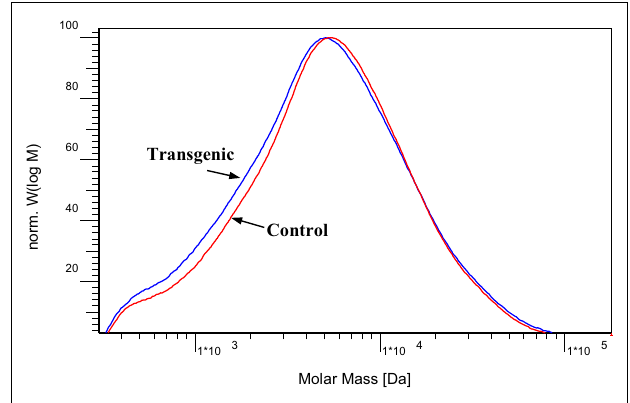
FIGURE 8 | Molecular weight distribution curves of acetylated lignin isolated from the wild-type and COMT transgenic switchgrass .